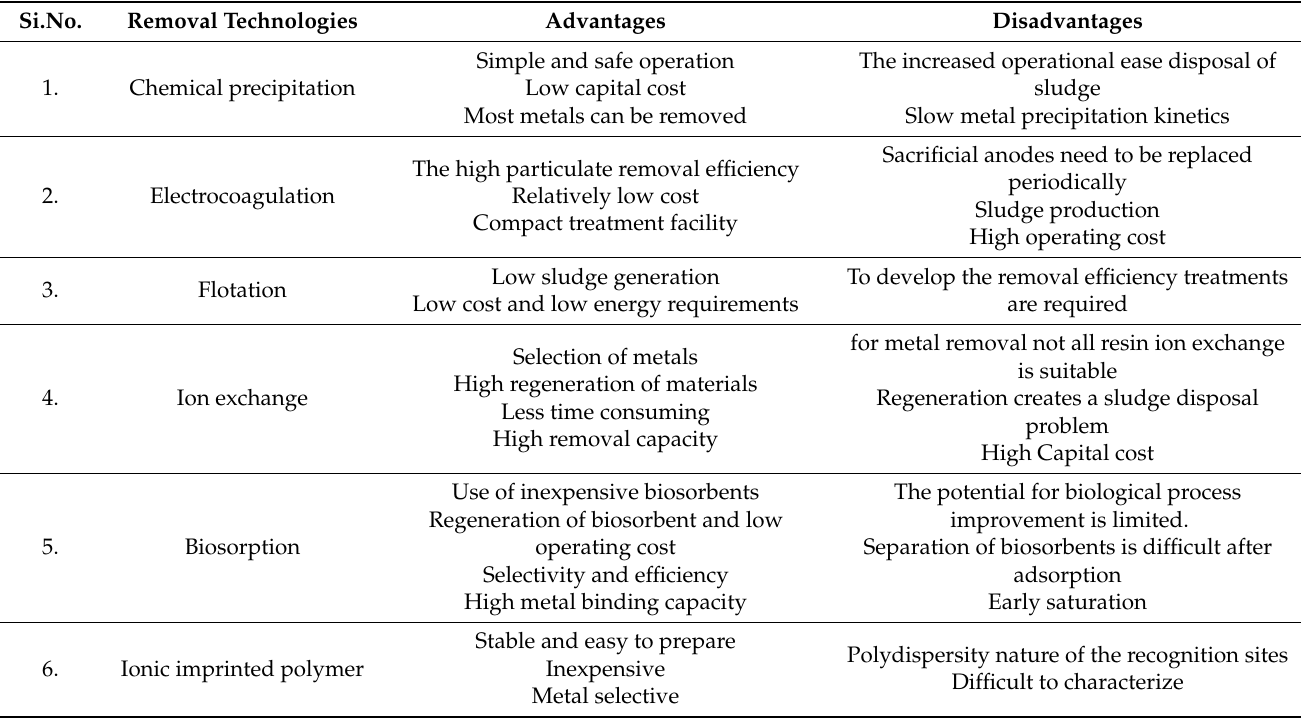
Table 3. Summary of the advantages and the disadvantages of the different physicochemical technologies for treatment of rare earth elements in water and wastewater [72].